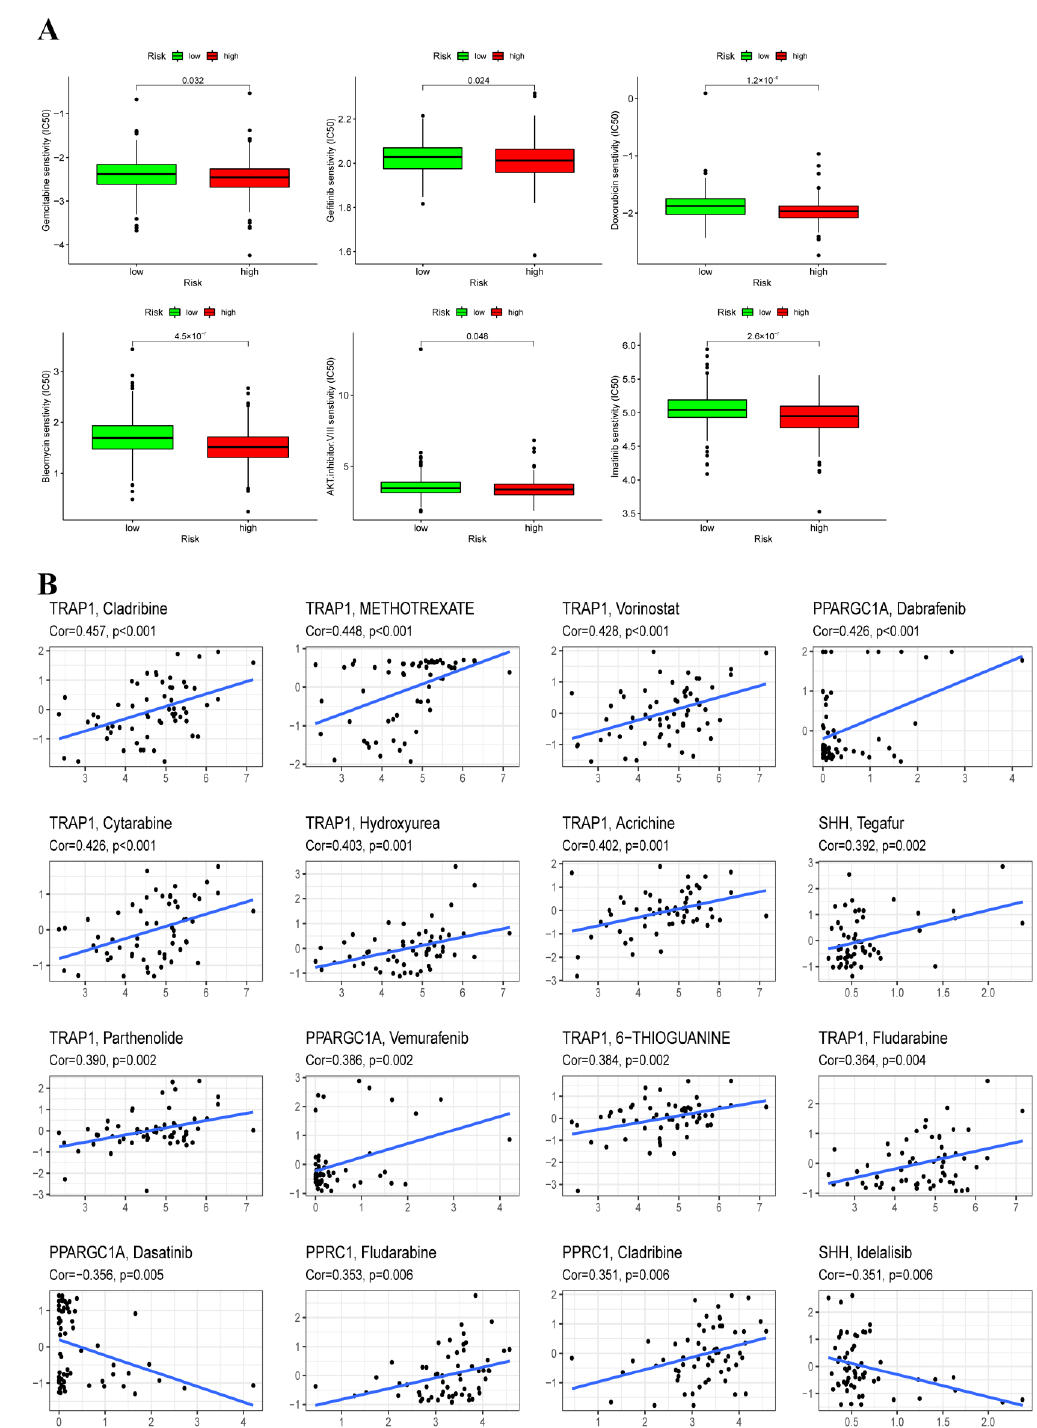
Figure 9. Prediction of the response to common chemotherapy drugs between the low-risk and high-risk groups. ( A ) Estimation of IC50 value for Gemcitabine, Gefitinib, Cisplatin, Bleomycin, AKT. inhibitor. VIII, Imatinib. ( B ) Scatter plot of the association between three ORGs expression and drug